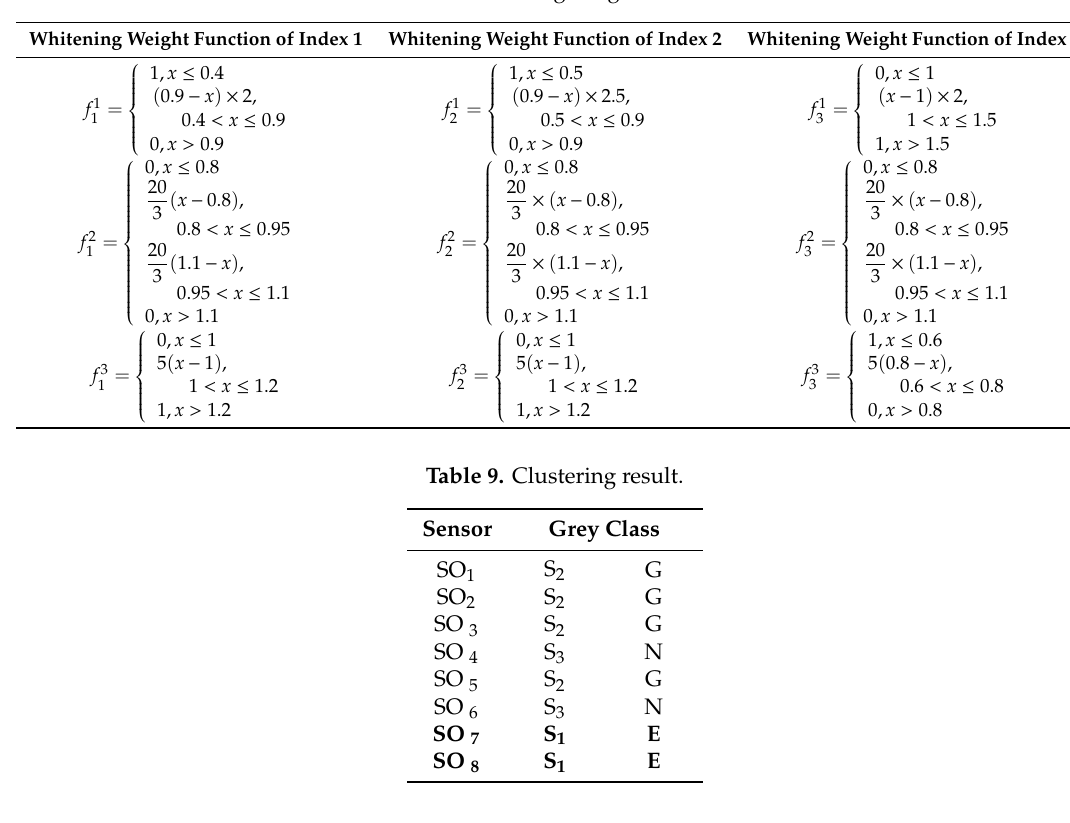
Table 8. Whitening weight function.